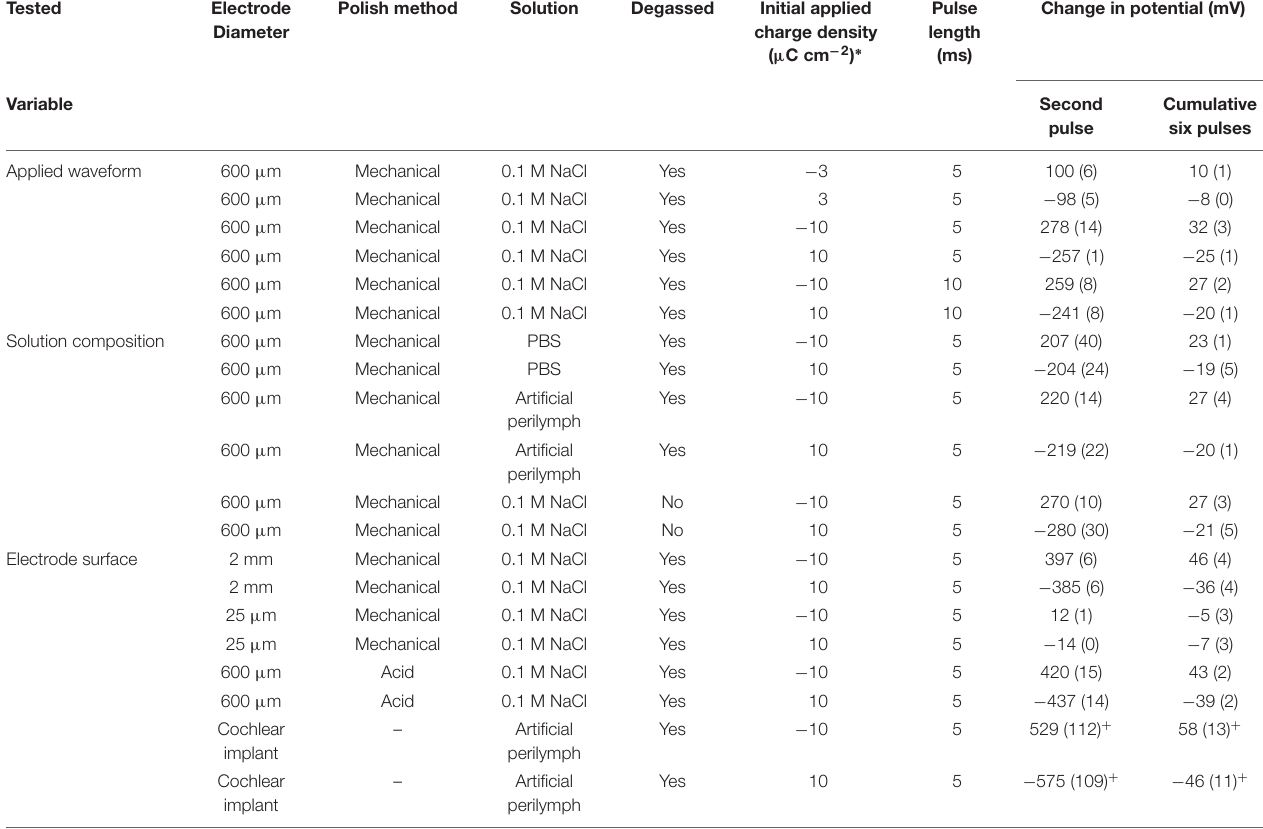
TABLE 1 | Change in potential on a platinum electrode from different chronopotentiometric conditions. Tested Electrode Polish method Solution Degassed Change in potential (mV) Diameter